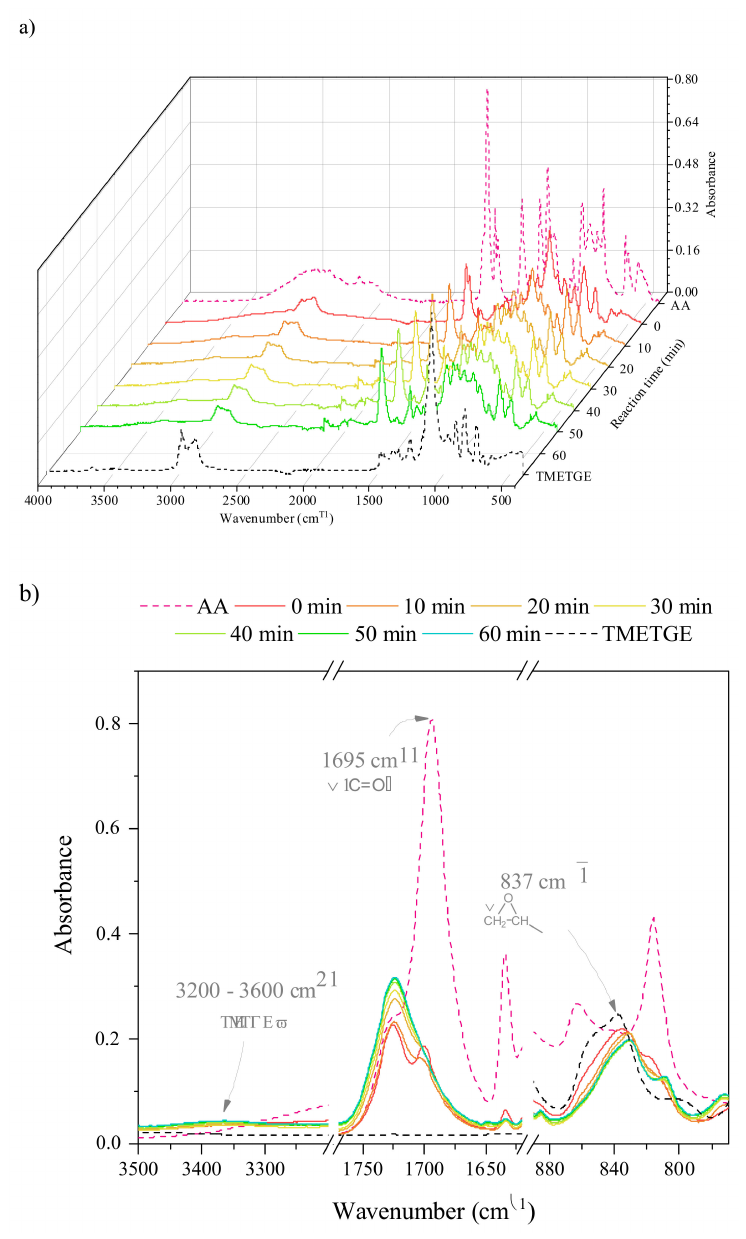
Figure 2. FTIR spectra of TMETGE resin, methacrylic acid, and prepolymers as a function of the reaction time: ( a ) 3D representation, ( b ) an enlarged view of the IR spectra in the range typical for carbonyl, epoxy, and a hydroxyl